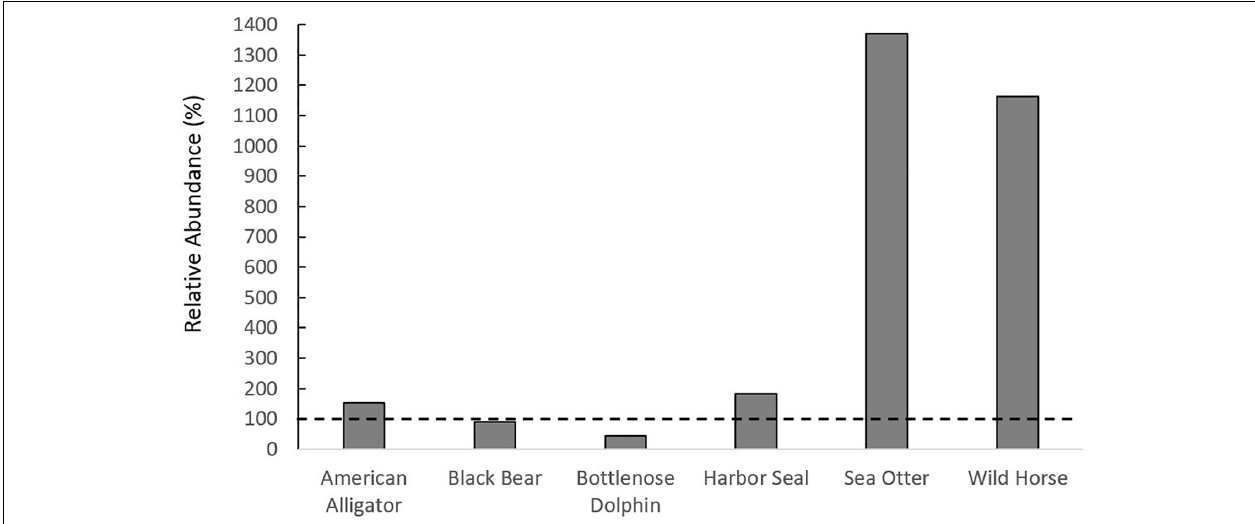
FIGURE 2 | Relative abundance of megafauna in salt marshes compared to other habitats in which they are found. If above the dashed horizontal line, the species of megafauna is more abundant in salt marshes than other